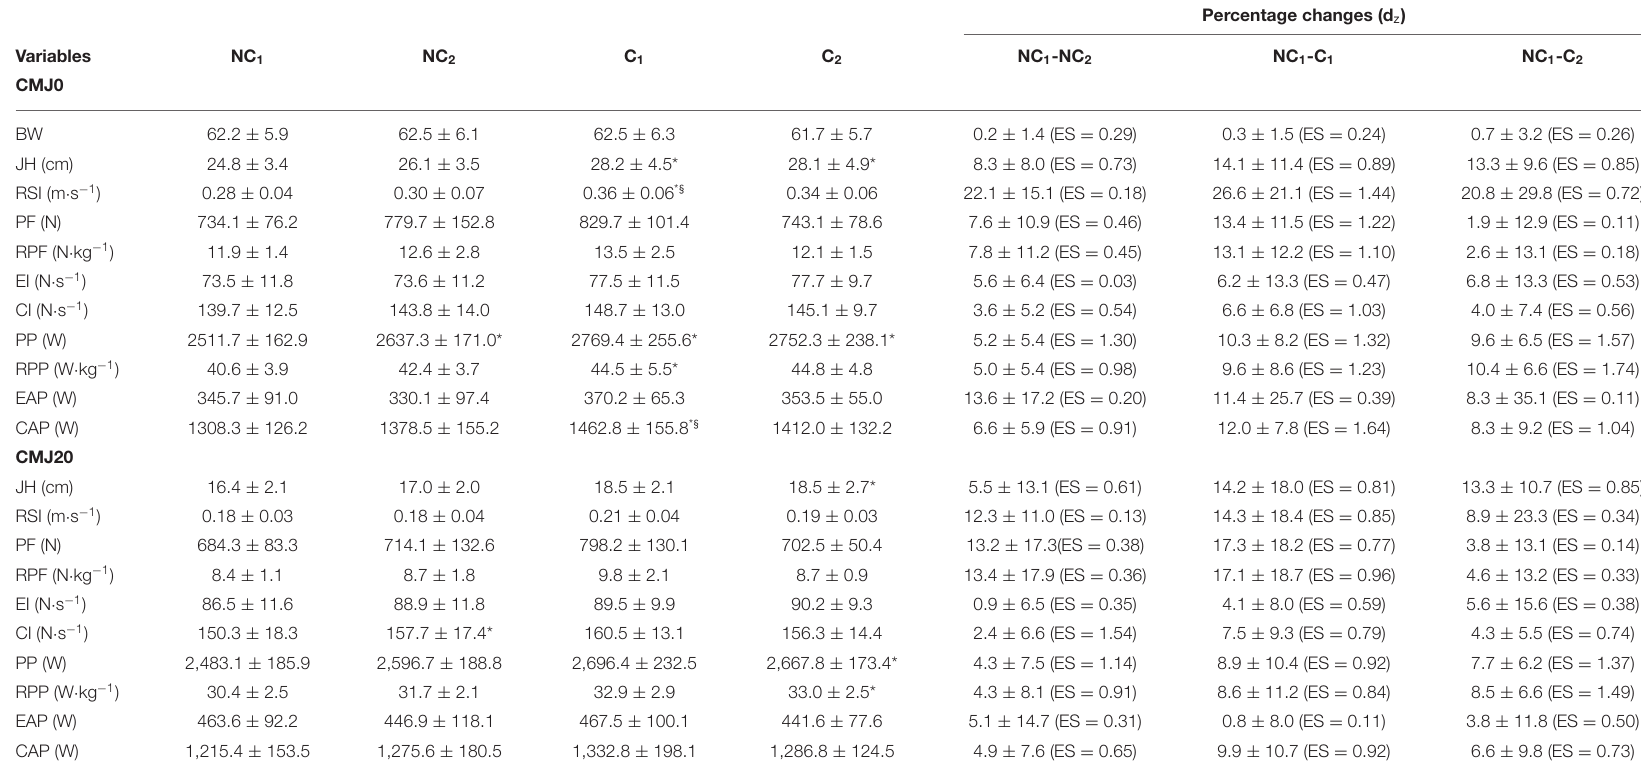
TABLE 2 | Seasonal changes in unloaded and loaded countermovement jump